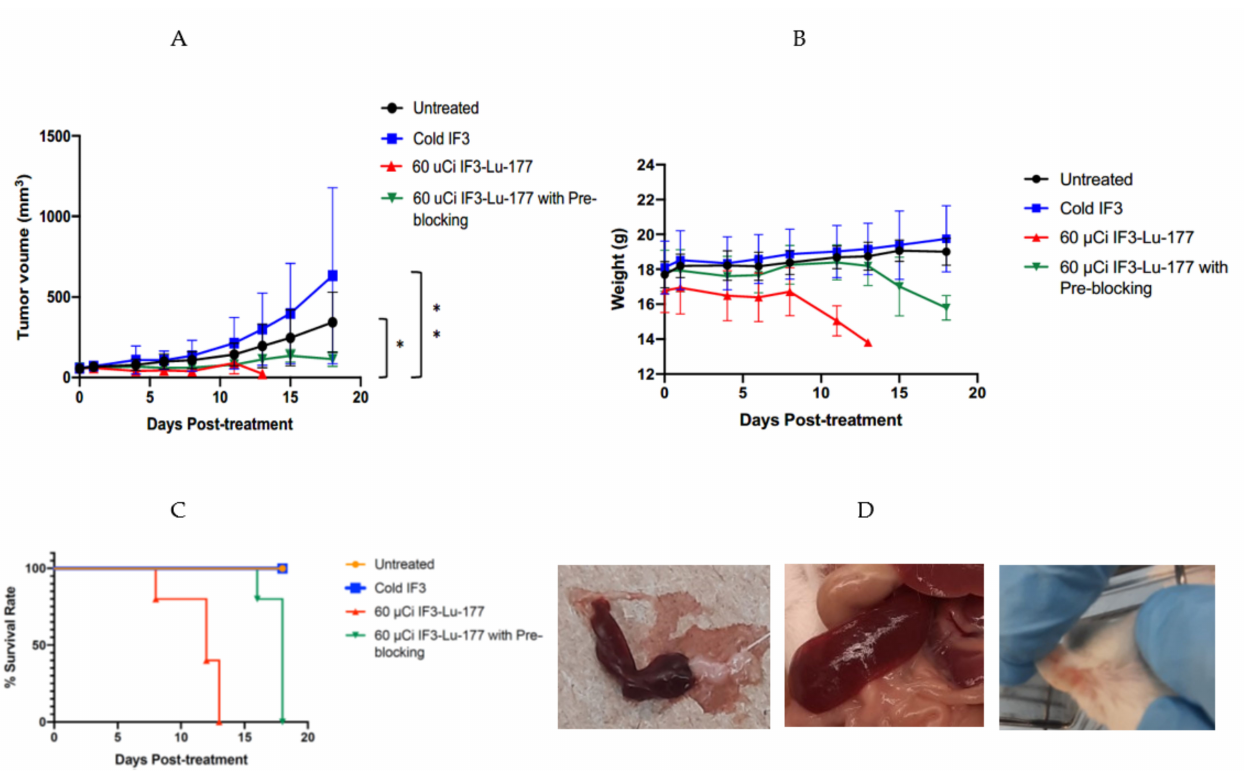
Figure 3. RIT of SCID mice bearing Gracie tumors with 177 Lu-IF3 mAb: ( A ) tumor volume; ( B ) mouse body weight; ( C ) Kaplan–Meier survival curves. Groups of 5 mice were treated with either: 60 µ Ci 177 Lu-IF3 mAb; or 60 µ Ci 177 Lu-IF3 mAb preceded by 200 µ g of “cold” IF3 antibody 2 h before RIT; or 12 µ g “cold” IF3 mAb; or left untreated; ( D ) gross pathology of the mice post-mortem: left plate— spleen of RIT-alone-treated mouse; middle plate—spleen of untreated mouse; right plate—petechiae on the ears of RIT-alone-treated mouse. * means p = 0.01, ** means p =